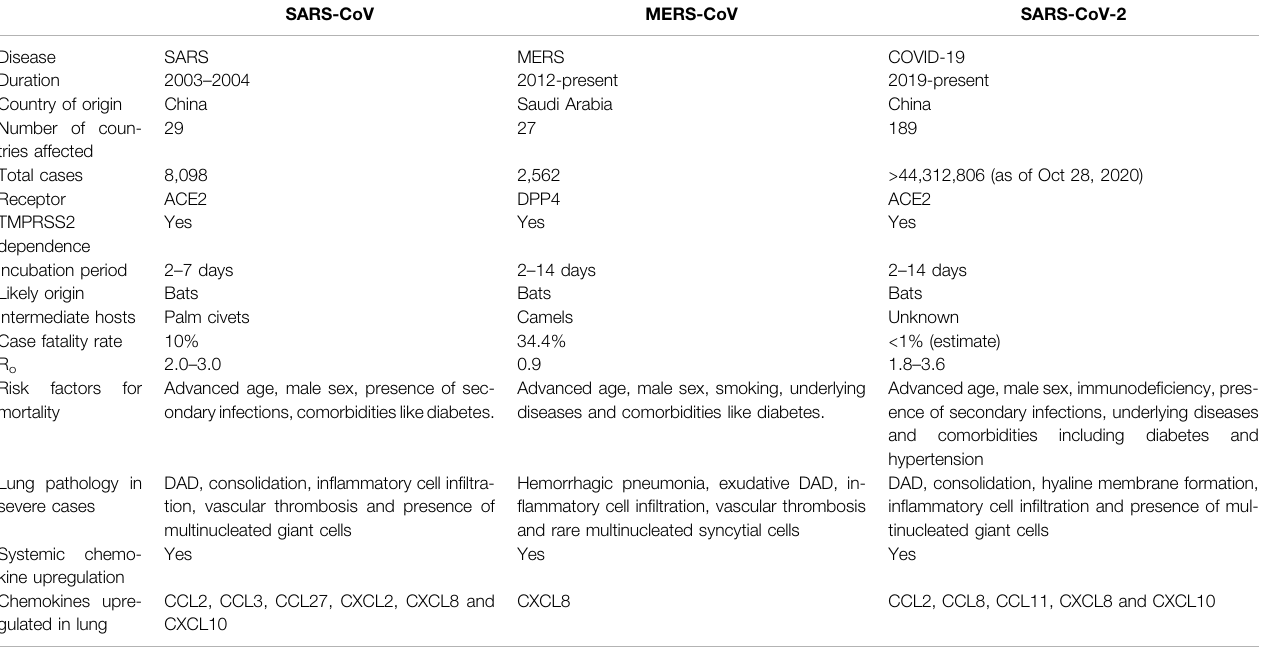
Table 5 | Comparison of major features of the epidemic